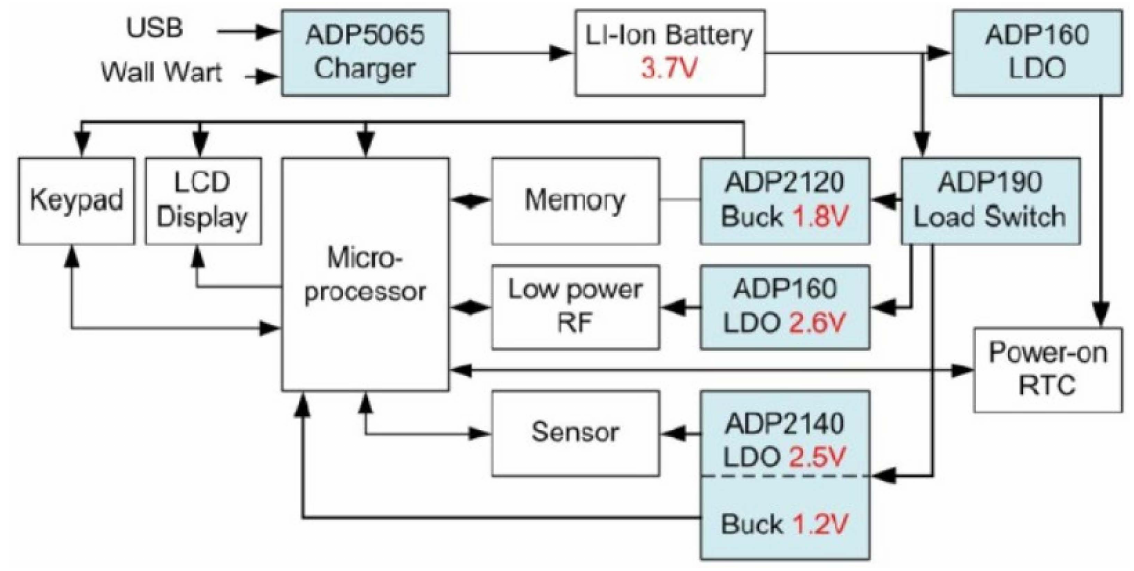
Figure 9. Subsystems of a portable device